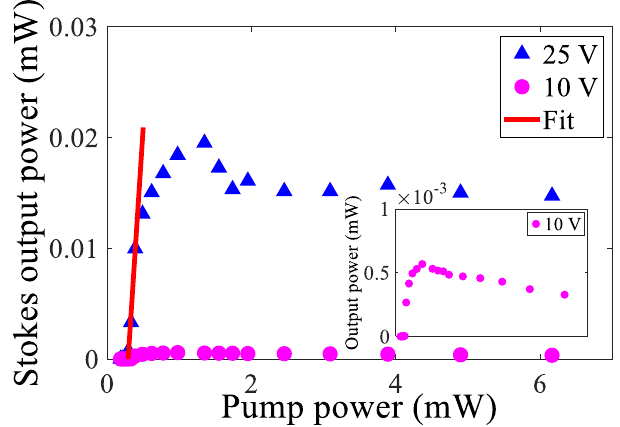
Fig. 3 Stokes Raman laser output power as a function of pump power at pump wavelength of 1550 nm with 25 and 10 V reverse biases. The inset is the zoom-in image for the 10 V reverse bias. The linear fi tting curve shows the slope ef fi ciency to be 10% at 25 V reverse